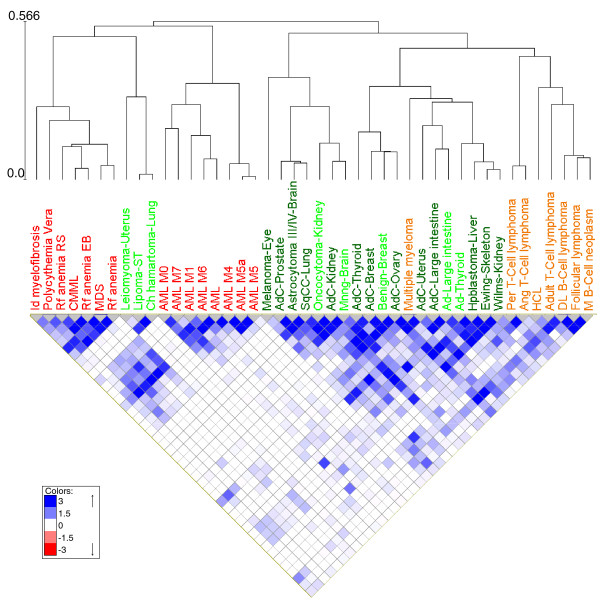
Hierarchical clustering of classes based on class similarity in sharing common aberrations. The square at the intersection of each two diagonals shows the similarity of their classes as measured by the aberrations associated with them (Materials and methods). (An aberration was associated with a tumor class if the correlation had a (uncorrected) P-value < 0.05.) Names of cancer classes are colored as follows: orange, lymphoid disorders; red, non-lymphoid hematological disorders; light green, benign solid tumors; dark green, malignant solid tumors. Classes that showed no significant similarity to any other class at FDR 5% were not included in the clustering.